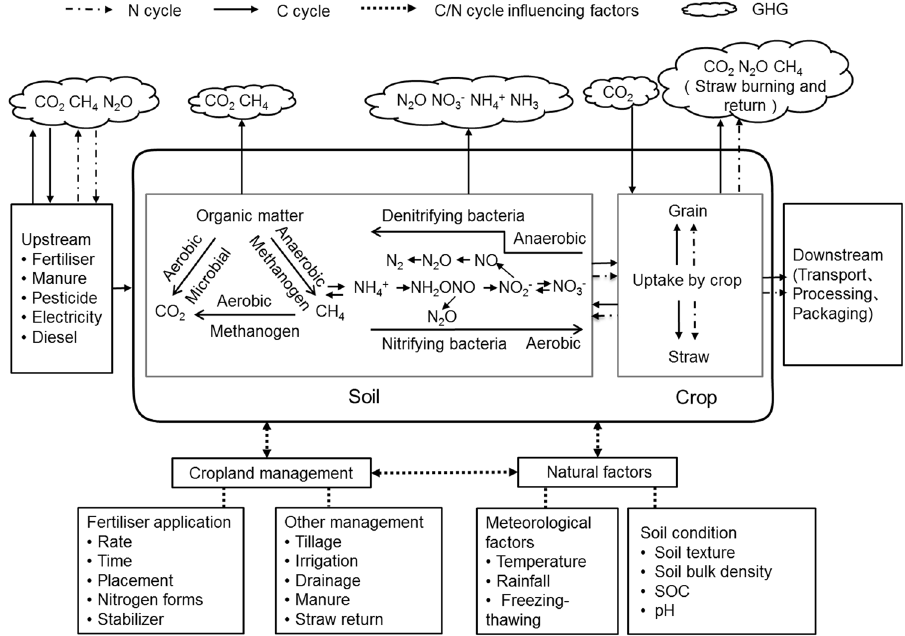
Figure 3. A theoretical model of the carbon footprint of crop production 6